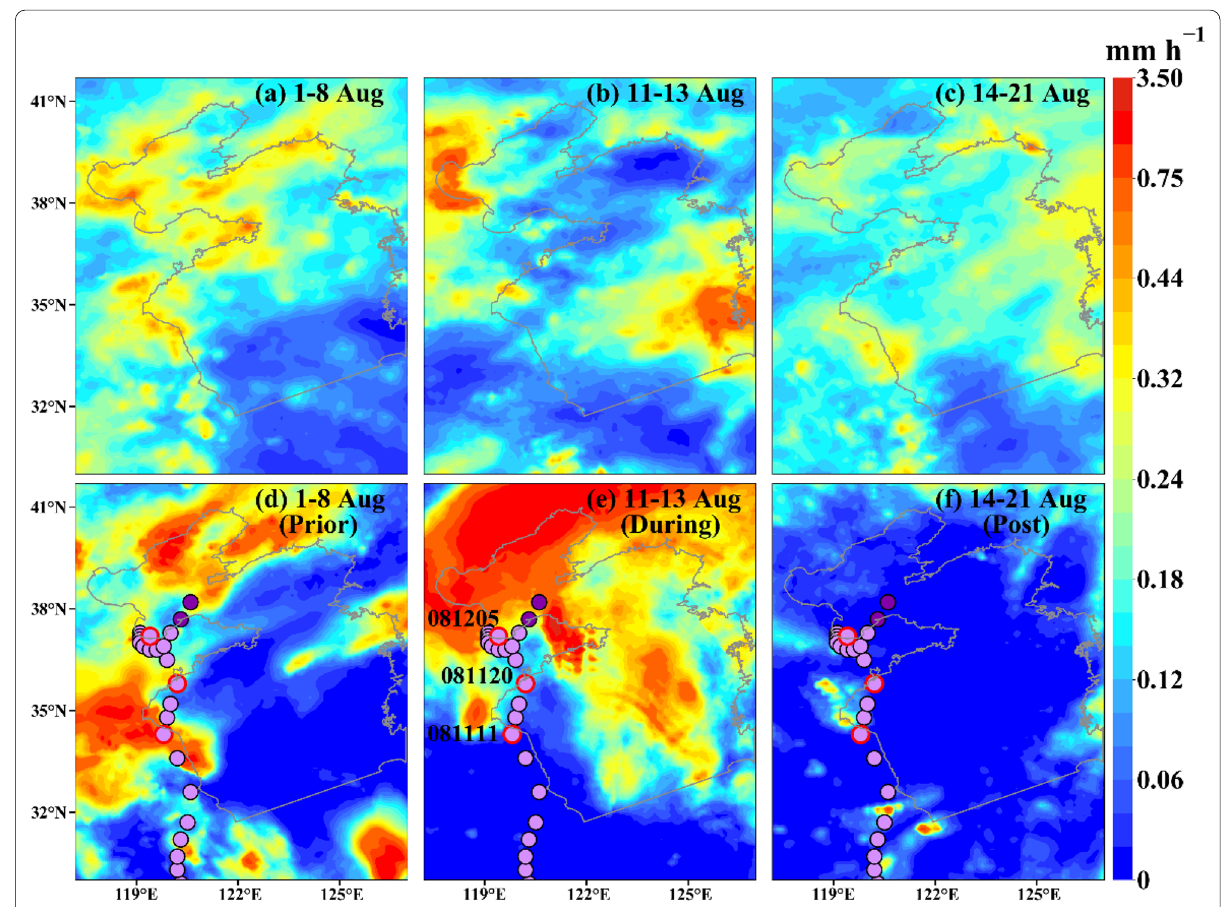
Fig. 3 Rainfall during 1–8th August ( a , d ), 11–13th August ( b , e ), and 14–21st August ( c , f ) for non‑typhoon years (top panel) and 2019 (lower panel) in the Yellow‑Bohai